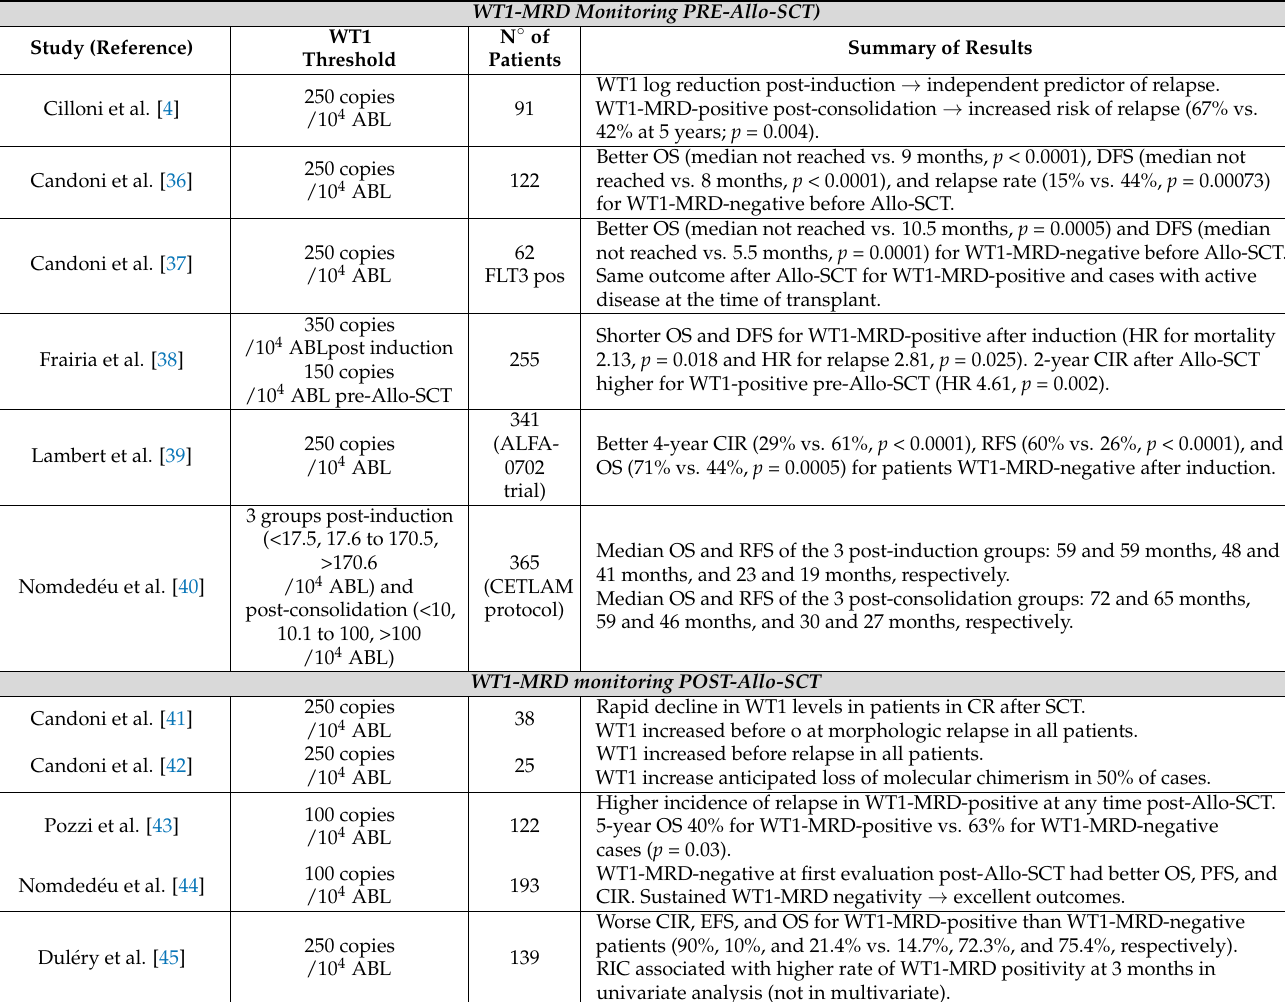
Table 1. Summary of studies exploring the role of WT1-MRD monitoring in BM. WT1-MRD Monitoring